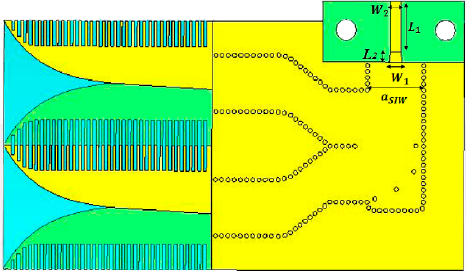
Figure 9. Fabricated prototypes of H-plane SIW antenna arrays with two-way and three-way right- angled power dividers and size comparison with a Canadian two-dollar coin. Figure 10. Vivaldi antenna array with two-way out-of-phase SIW power divider as feed system. W 1 =